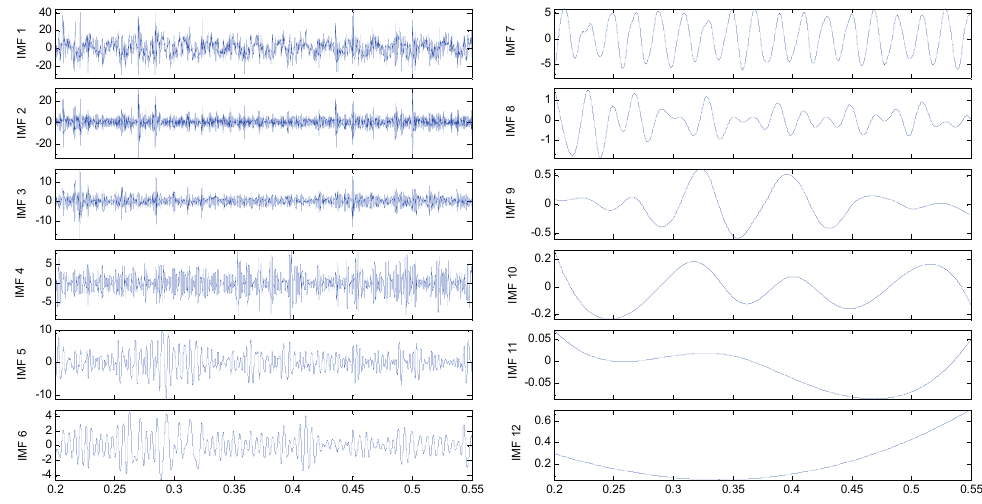
Figure 14. Vibration signal of an axle bearing with a composite of three kinds of faults.